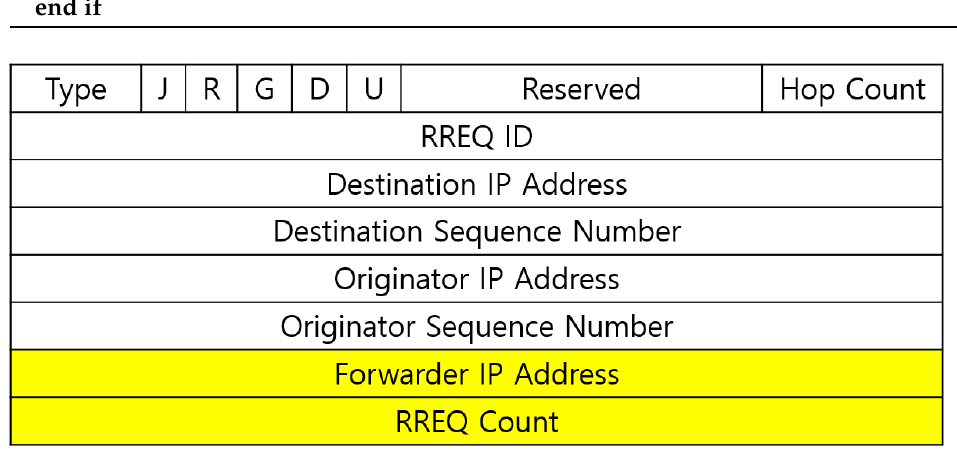
Figure 5. Modified RREQ message